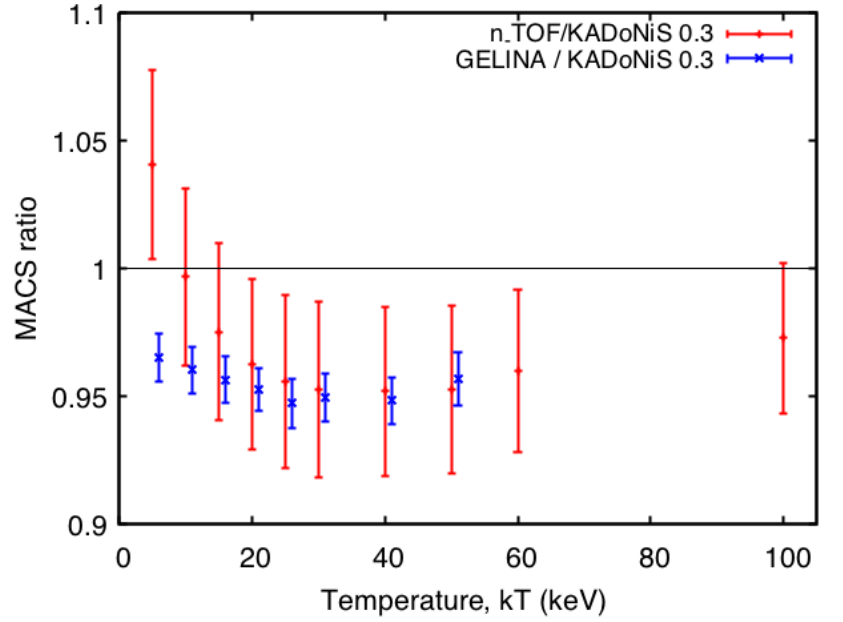
Figure 3. Ratio of the 197 Au(n, γ ) MACSs reported in the KADONiS 0.3 database with respect to the n_TOF and GELINA experimental data. To avoid an overlap of points the values corresponding to the GELINA data are displaced along the x-axis by 1